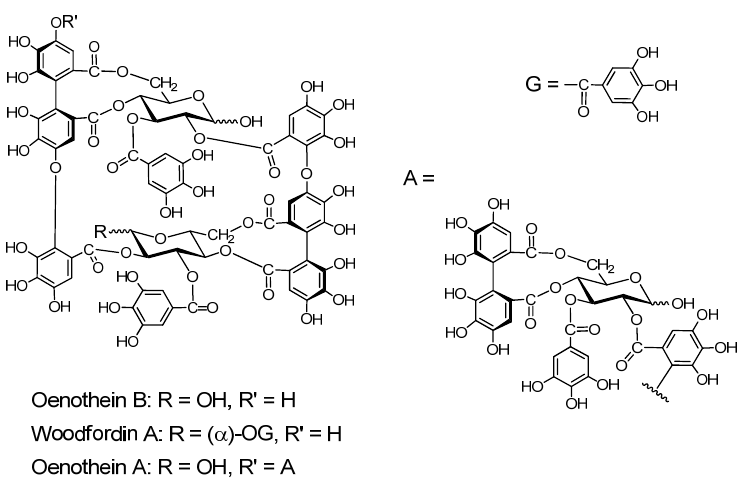
Figure 7. Macrocyclic ellagitannin